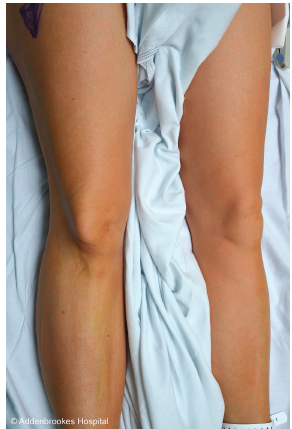
Figure 3: Anterior-posterior radiograph of the knee with a laterally dislocated patella.